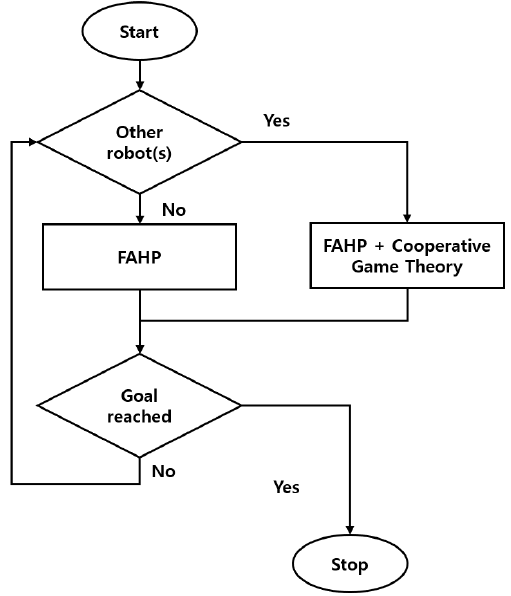
Figure 2. Multi-robot navigation strategy. FAHP: Fuzzy Analytic Hierarchy